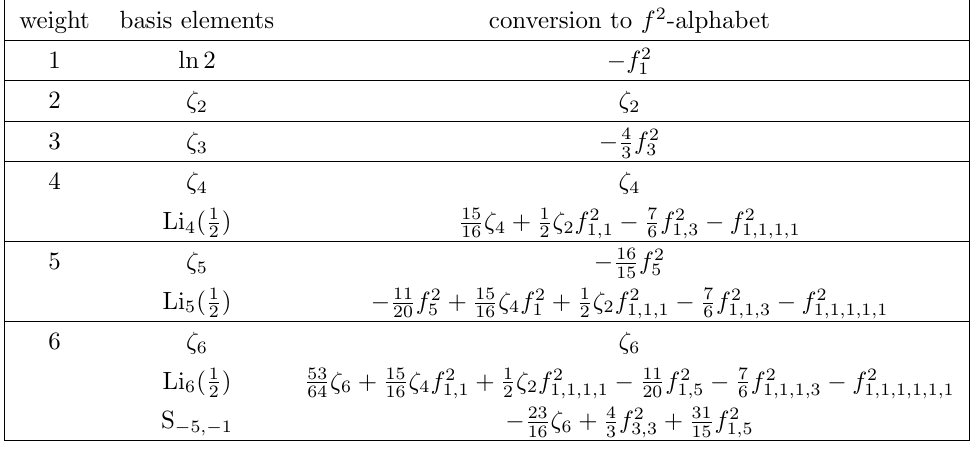
Table 15 . Indecomposable basis elements for alternating sums at the (cid:12)rst few weights. The generating function for the maximal set of functions with symbol letters y; 1 (cid:0) y; 1 + y and no branch cuts except at u = 0 ; 1 is then just the